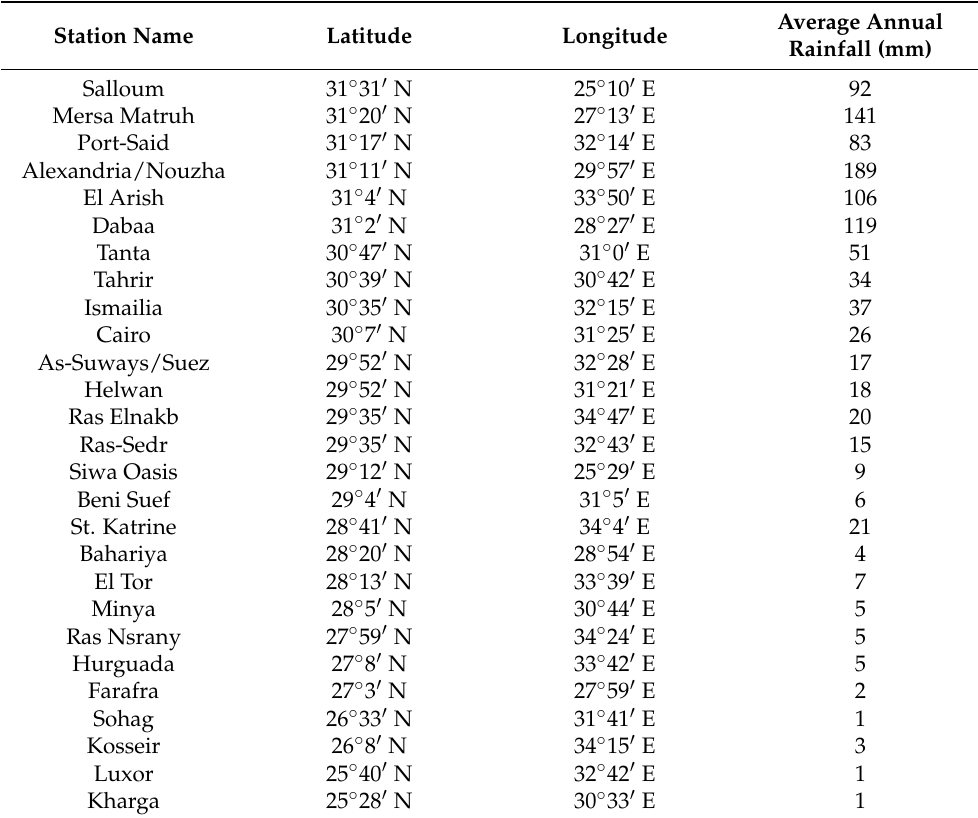
Table 1. Average annual rainfall (mm) over Egypt stations (Egyptian Meteorological Authority